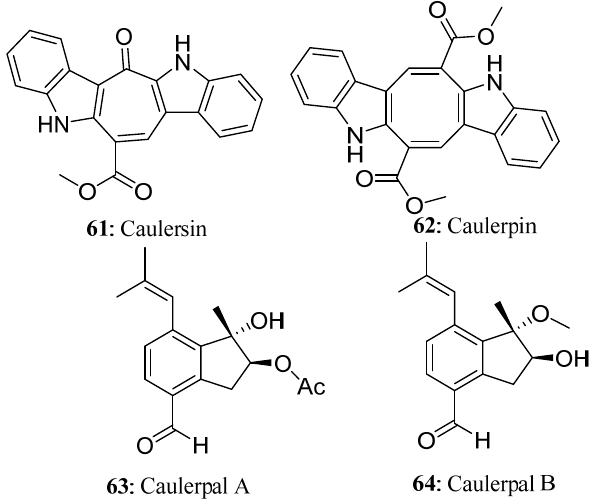
Figure 12. Structures of compounds 61 – 64 .